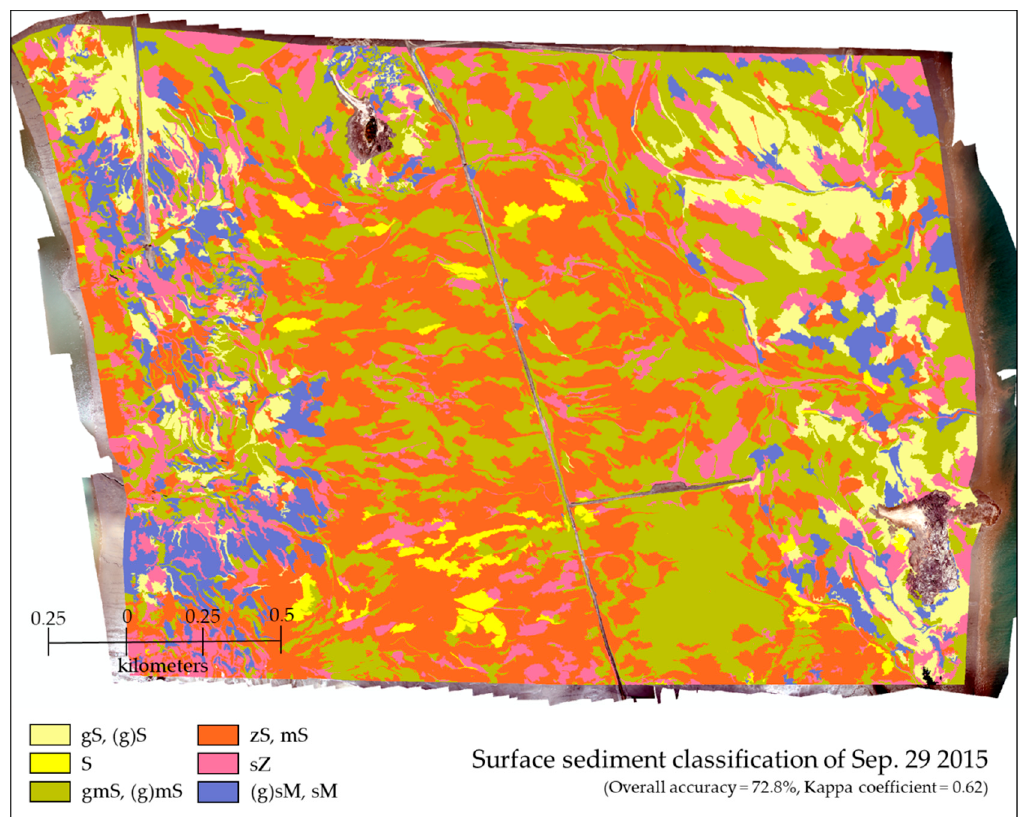
Figure 6 . Large-scale surface sediment classification map derived from the UAV RGB orthoimage. The overall accuracy is 72.8%, with a 5-m error range, and the Kappa coefficient is 0.62. Table 3. Accuracy assessment of the surface sediment classification. The overall accuracy is 72.83%, and the Kappa coefficient is 0.62.